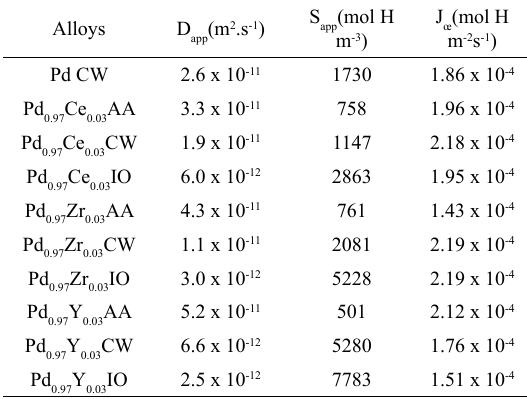
Table 1. Hydrogen permeation parameters of pure Pd and Pd alloys at 313 K for cathodic charging current equal to 1